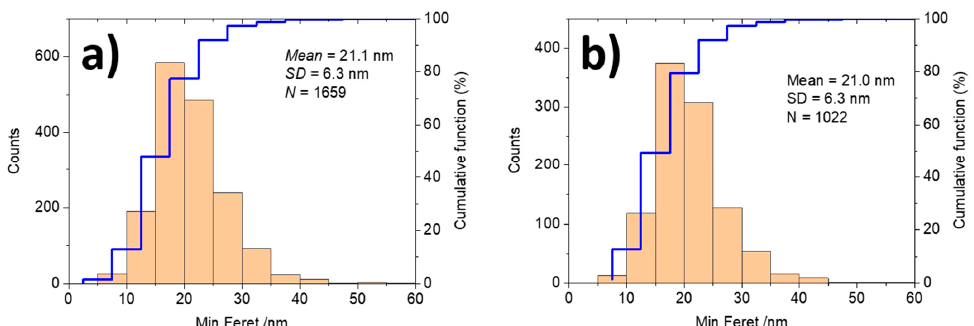
Figure 3. Particle size (minimum Feret diameter) distribution of the titanium dioxide nanoparticles as imaged with SEM in Figure 2: ( a ) JRCNM62001a and ( b ) JRCNM62002a.